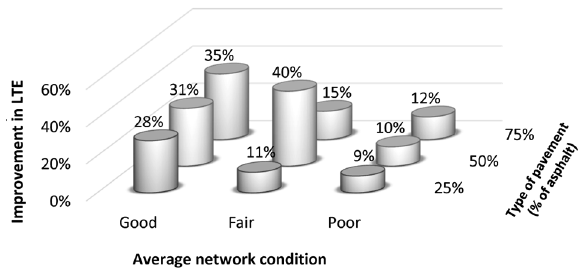
Fig. 4. Improvement in LTE obtained with the proposed optimization algorithm considering different inventory